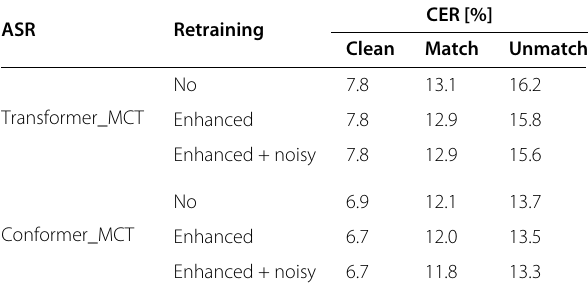
Table 4 CER [%] results of the SE_ASR system retraining with and without noisy features